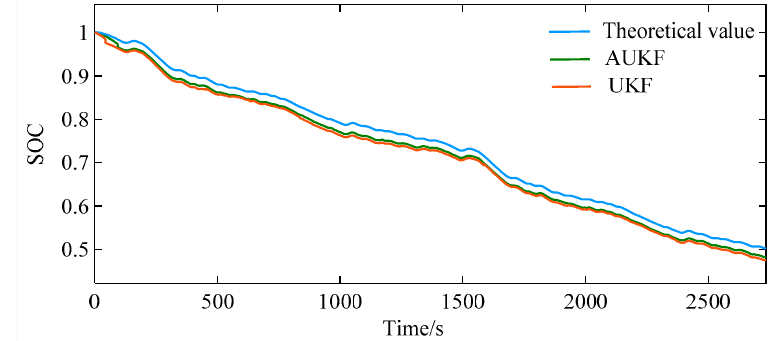
Figure 12. The model simulation results.